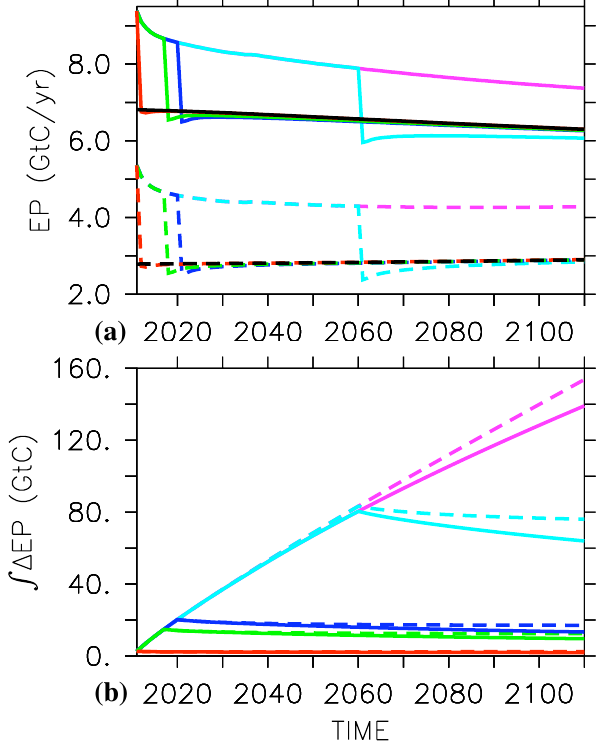
Fig. 5. (a) Simulated annual export production across z =125m south of 30 ◦ S (dashed lines) and integrated over the global ocean (solid lines). Units are GtC/yr. (b) Cumulative temporal integral of the fertilization-induced change in export production south of 30 ◦ S (dashed lines) and for the global ocean (solid lines). Units are GtC. Black line in (a) is the control experiment without iron fertilization. Note that simulated export production decreases from 6.8GtC/yr in 2010 to 6.3GtC/yr in 2100 in response to global warming. Coloured lines refer to the different fertilization experiments, stopping fertil- ization after 1 year (red), 7 years (green), 10 years (blue), 50 years (cyan) and not at all within the first 100 years